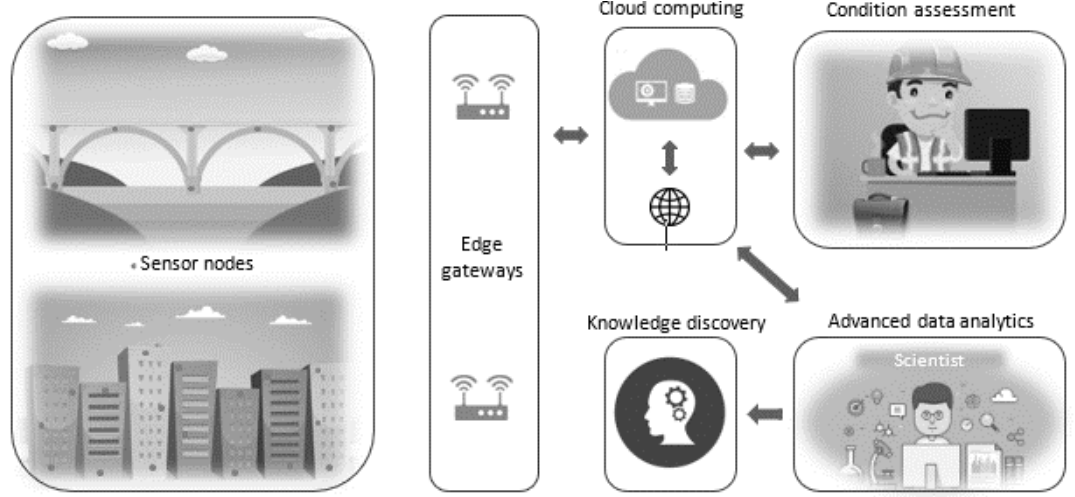
Figure 7. Schematic presentation of autonomous corrosion assessment.